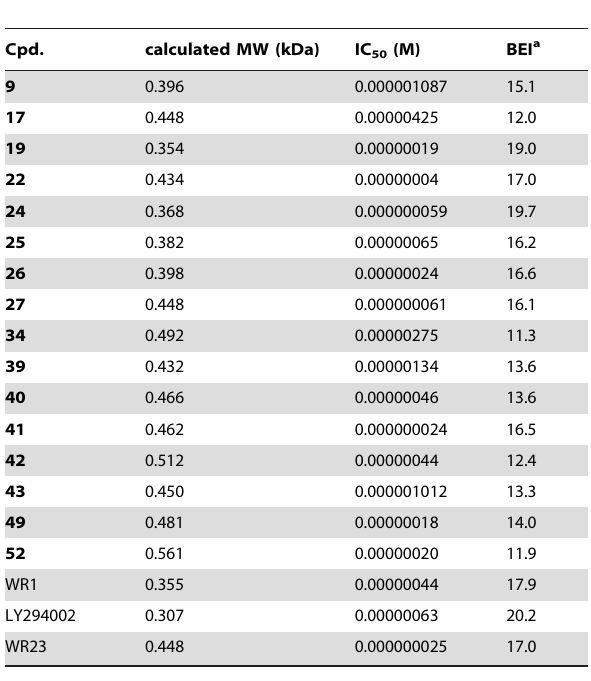
Table 5. Binding efficiency index (BEI) of selected target compounds.